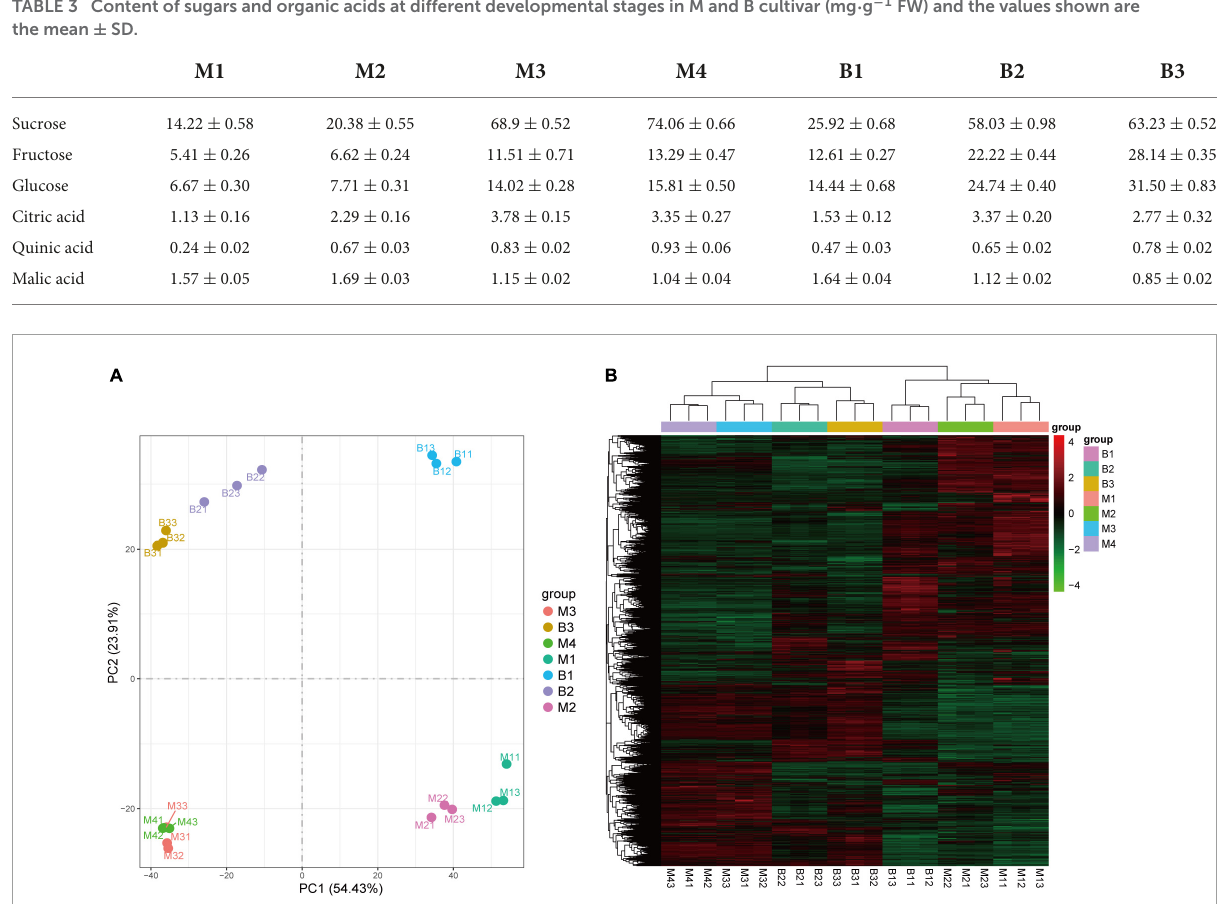
FIGURE4 PCA (A) and HCA (B) of genes in pineapple fruits at different developmental stages of M and B. M1, M2, M3, and M4 represented fruit flesh samples for M at 40, 80, 100, and 120 DAA, respectively, B1, B2, and B3 represented fruit flesh samples for B at 40, 80, and 100 DAA,